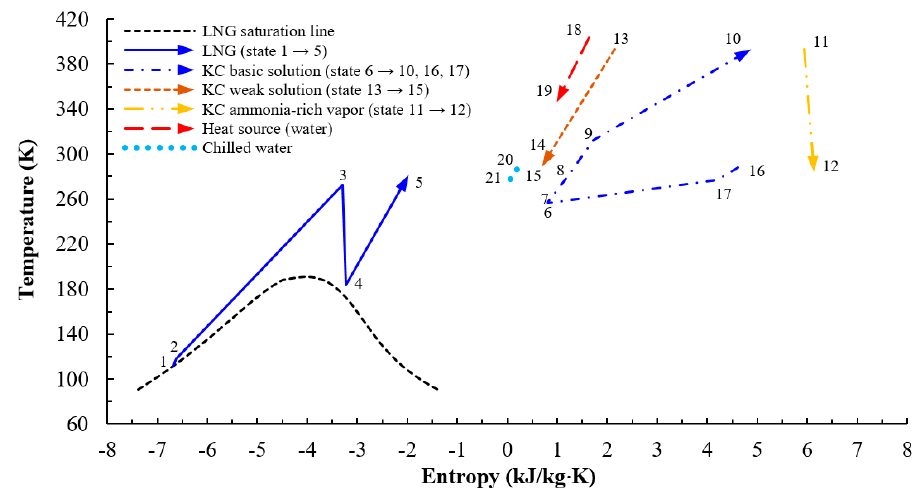
Figure 2. T-s diagram of the poly-generation system processes at nominal conditions.